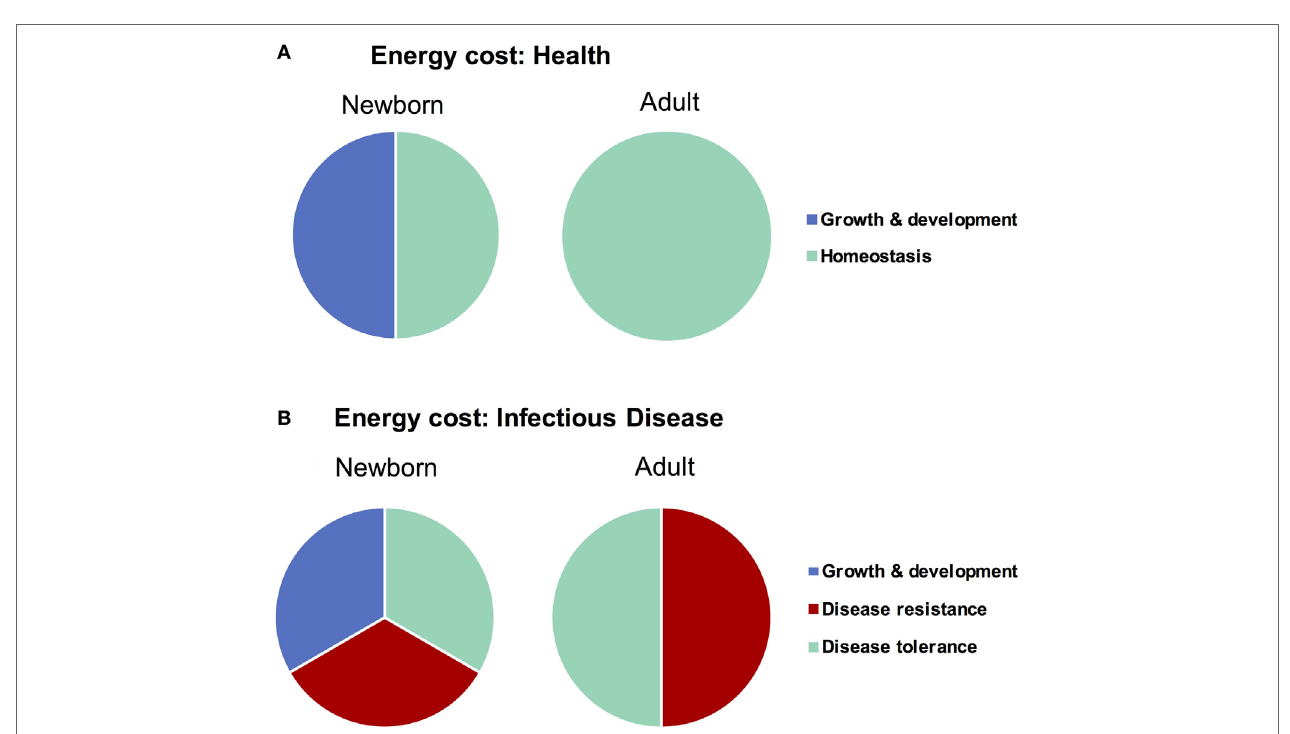
FiGUre 2 | Difference in energy demands of the newborn and adult as it relates to infectious disease. Newborns must devote a large amount of energy toward growth and development which adults are able to spend on maintaining homeostasis. When healthy (a) , these differences in energetic demands may not be important, though when fighting infectious disease (B) , the newborn is unable to expend the resources required to employ a strategy of disease resistance and must therefore rely more heavily on disease